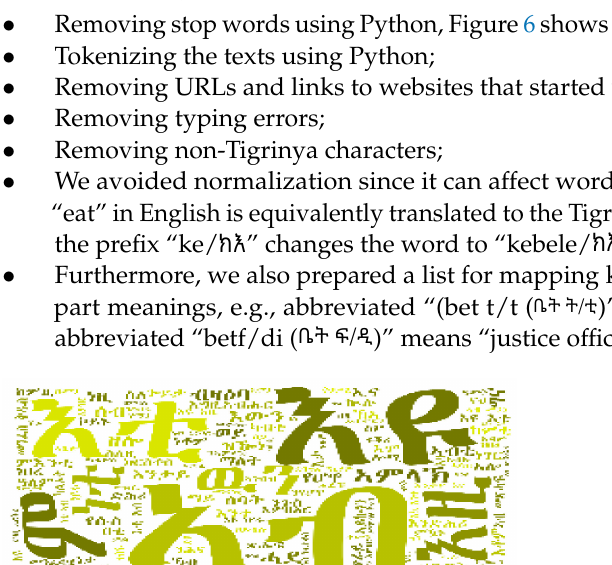
Figure 6. Stop word examples.